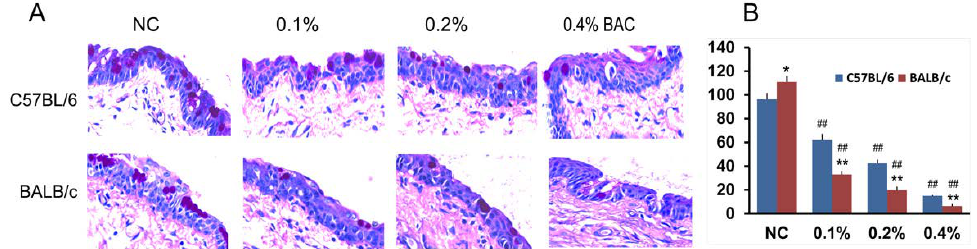
Figure 5. Evaluation of goblet cell number in the conjunctiva of mice that were treated with BAC eye drops: ( A ) Periodic acid-Schiff staining of the conjunctiva showing goblet cells within the epithelial layer of the C57BL/6 and BALB/c mice. Photos were magnified at 400×. ( B ) Quantification of goblet cells in the conjunctiva of the various treatment groups. Three different views of each section for one eye were randomly selected for counting, and the average of five eyes was calculated (cells/high-power visual field , 400×). *: p < 0.05; **, ##: p < 0.01; *, **: C57BL/6 vs. BALB/c; ##: test point vs. NC.